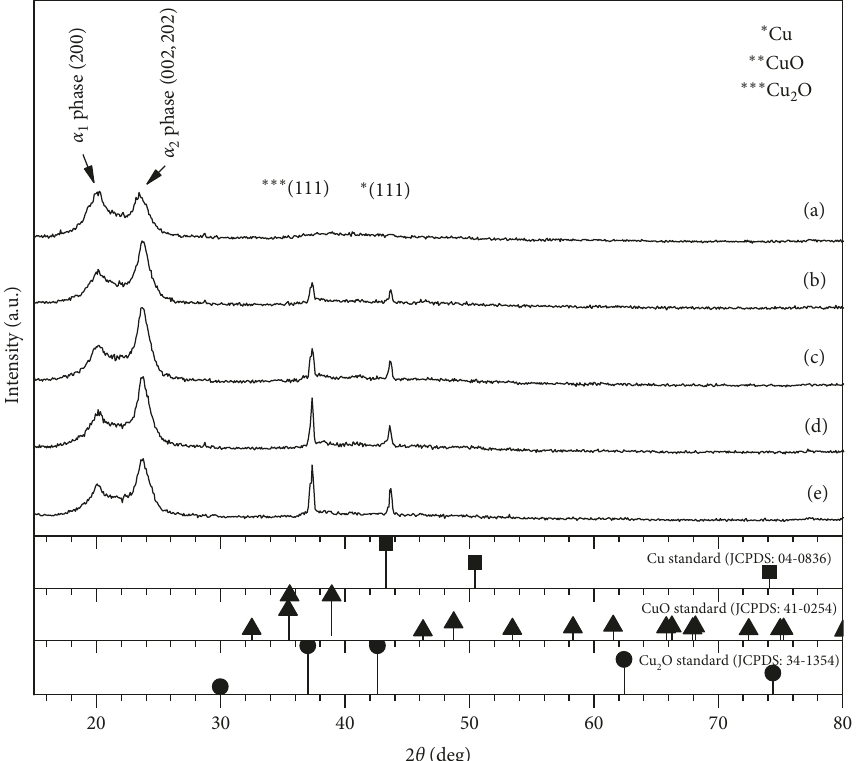
Figure 1: XRD diffractograms for all the samples: (a) pure nylon 6 and nanocomposites at the evaluated concentrations: (b) 0.01, (c) 0.05, (d) 0.10, and (e) 0.50wt.% of copper nanoparticles.